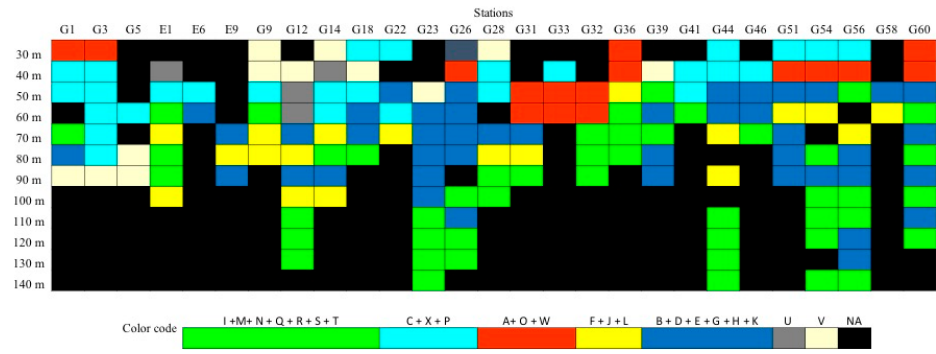
Figure 5. Color matrix after the grouping process, considering the SIMPER results of Table 1 and the union of different groups for the identification of biotic units. Table 1. Biological assemblage of each group considering the SIMPER analysis (A–T). The letters U, V, represent groups with 100% of coverage. Inside the parenthesis is the OTUs number of the species that most contributed to the differences.